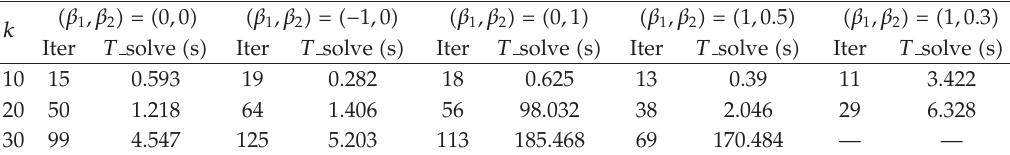
Table 2: Computational performance of GMRES with SLPs.